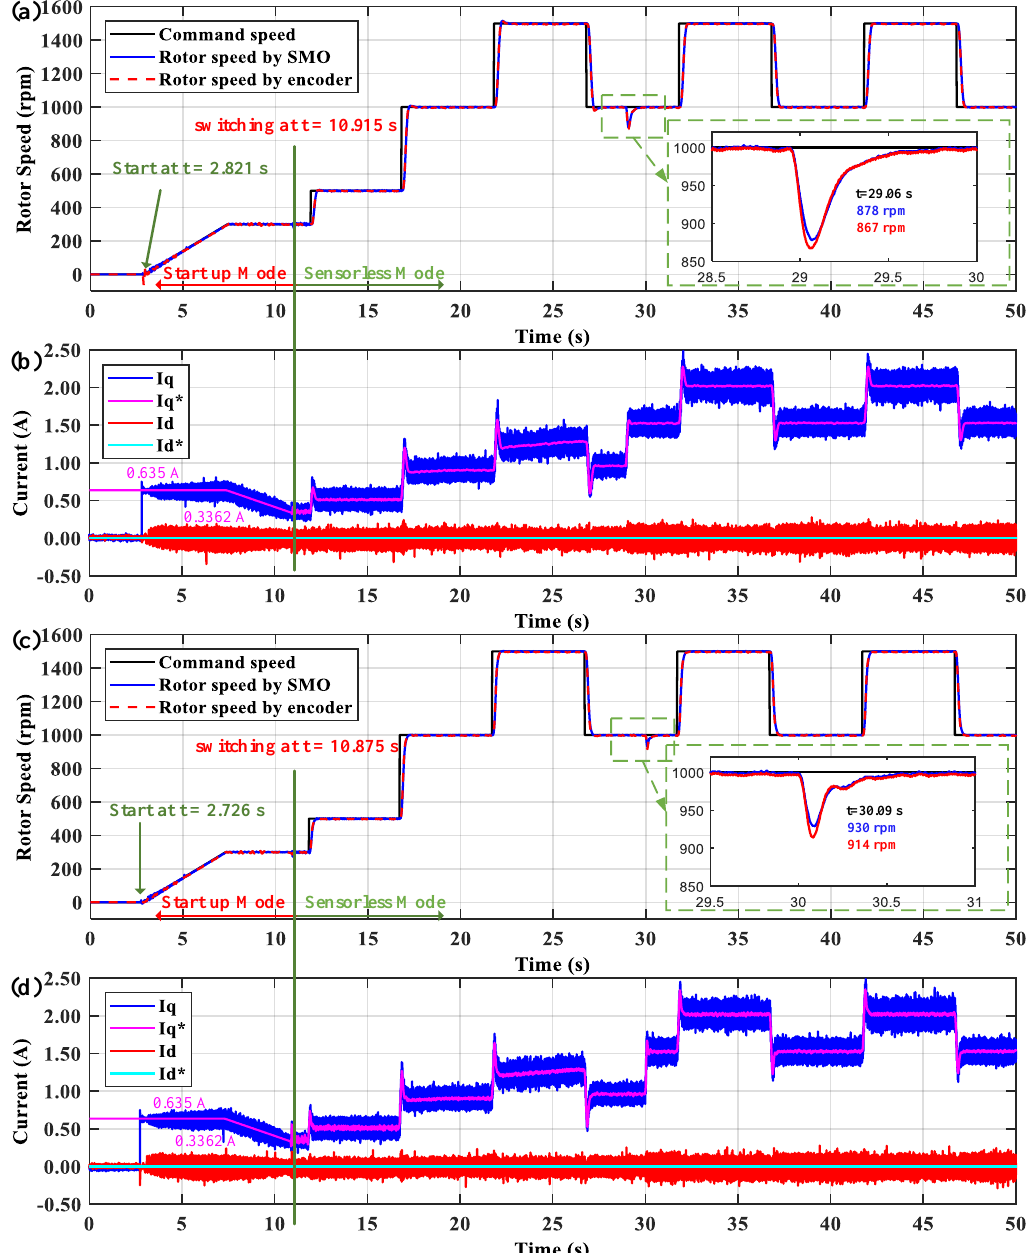
Figure 20. Experimental results for PI controller: ( a ) speed response; ( b ) current response; and for NFC controller: ( c ) speed response; and ( d ) current response in the case of R L = 100 → 50 Ω.